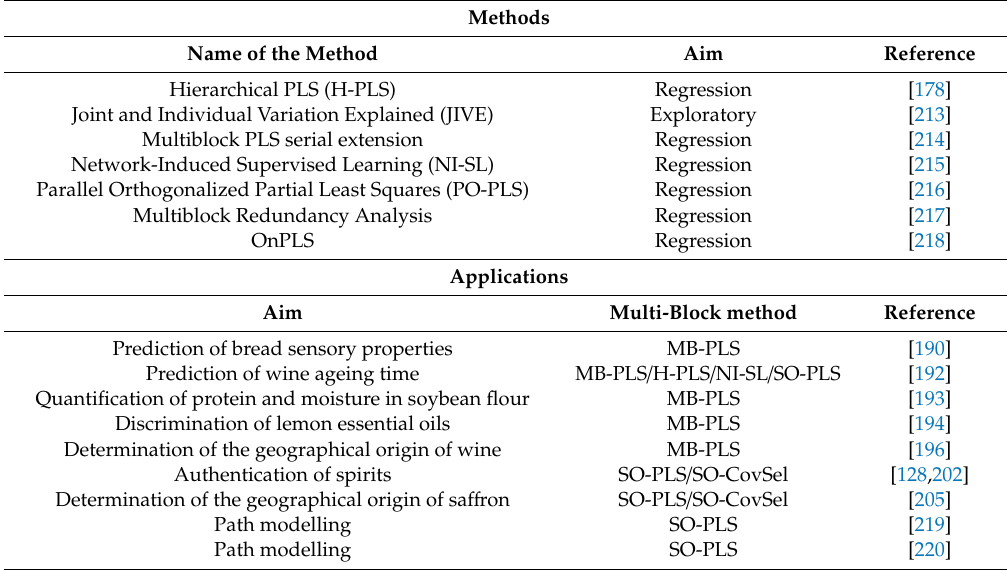
Table 3. Additional data fusion methods and application examples in the field of spectroscopy-based food analysis. MB-PLS, SO-PLS, SO-CovSel and OnPLS stand for Multi-Block-Partial Least Squares, Sequential and Orthogonalized-Partial Least Squares, Sequential and Orthogonalized Covariance Selection and n-block Orthogonal Projections to Latent Structures,